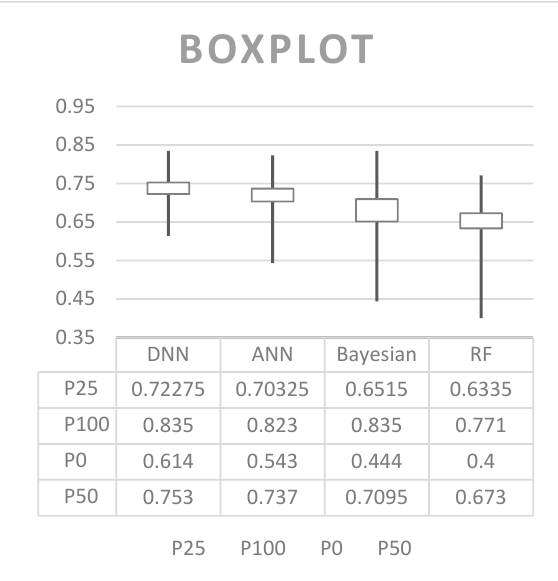
Figure 8. Boxplot between different algorithms.